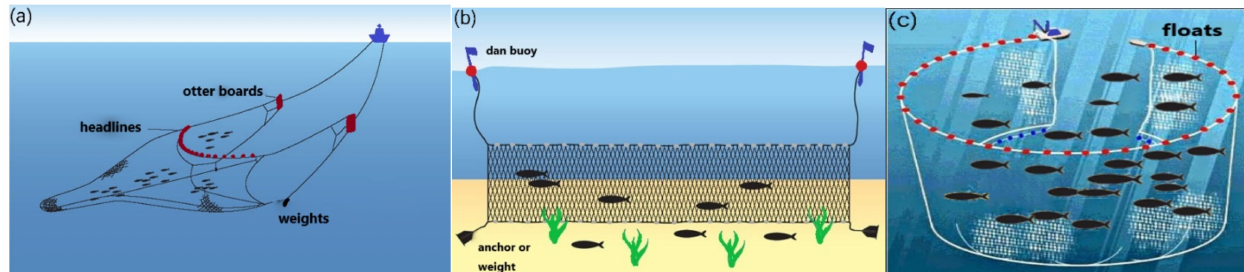
Figure 2. The schematic drawing of a trawler ( a ), a gillnetter ( b ) and a seiner ( c ). Gillnetters lay long ribbon-shaped nets vertically in the sea [40]. When fish try to cross the net, they are trapped in the mesh or entangled in the netting. After the nets are laid, gillnetters either moor or move slowly with the gear, generally at a speed of less than 2 knots. Their course may deviate to the left or right because of wind and waves. When the float at the top of the net begins to jiggle vigorously, the net is slowly pulled in. The entangled fish are pulled up, shaken out of the net, and thrown into the hold. The net is then reset, and the process begins again. The schematic diagram of a gillnetter is shown in Figure